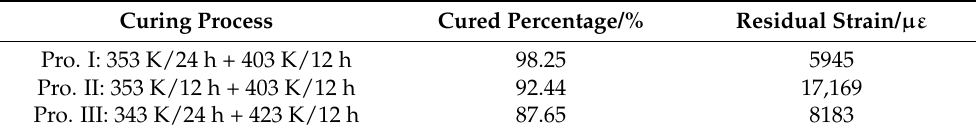
Table 1. Cured percentage and Residual strains of epoxy resin curing with different processes.